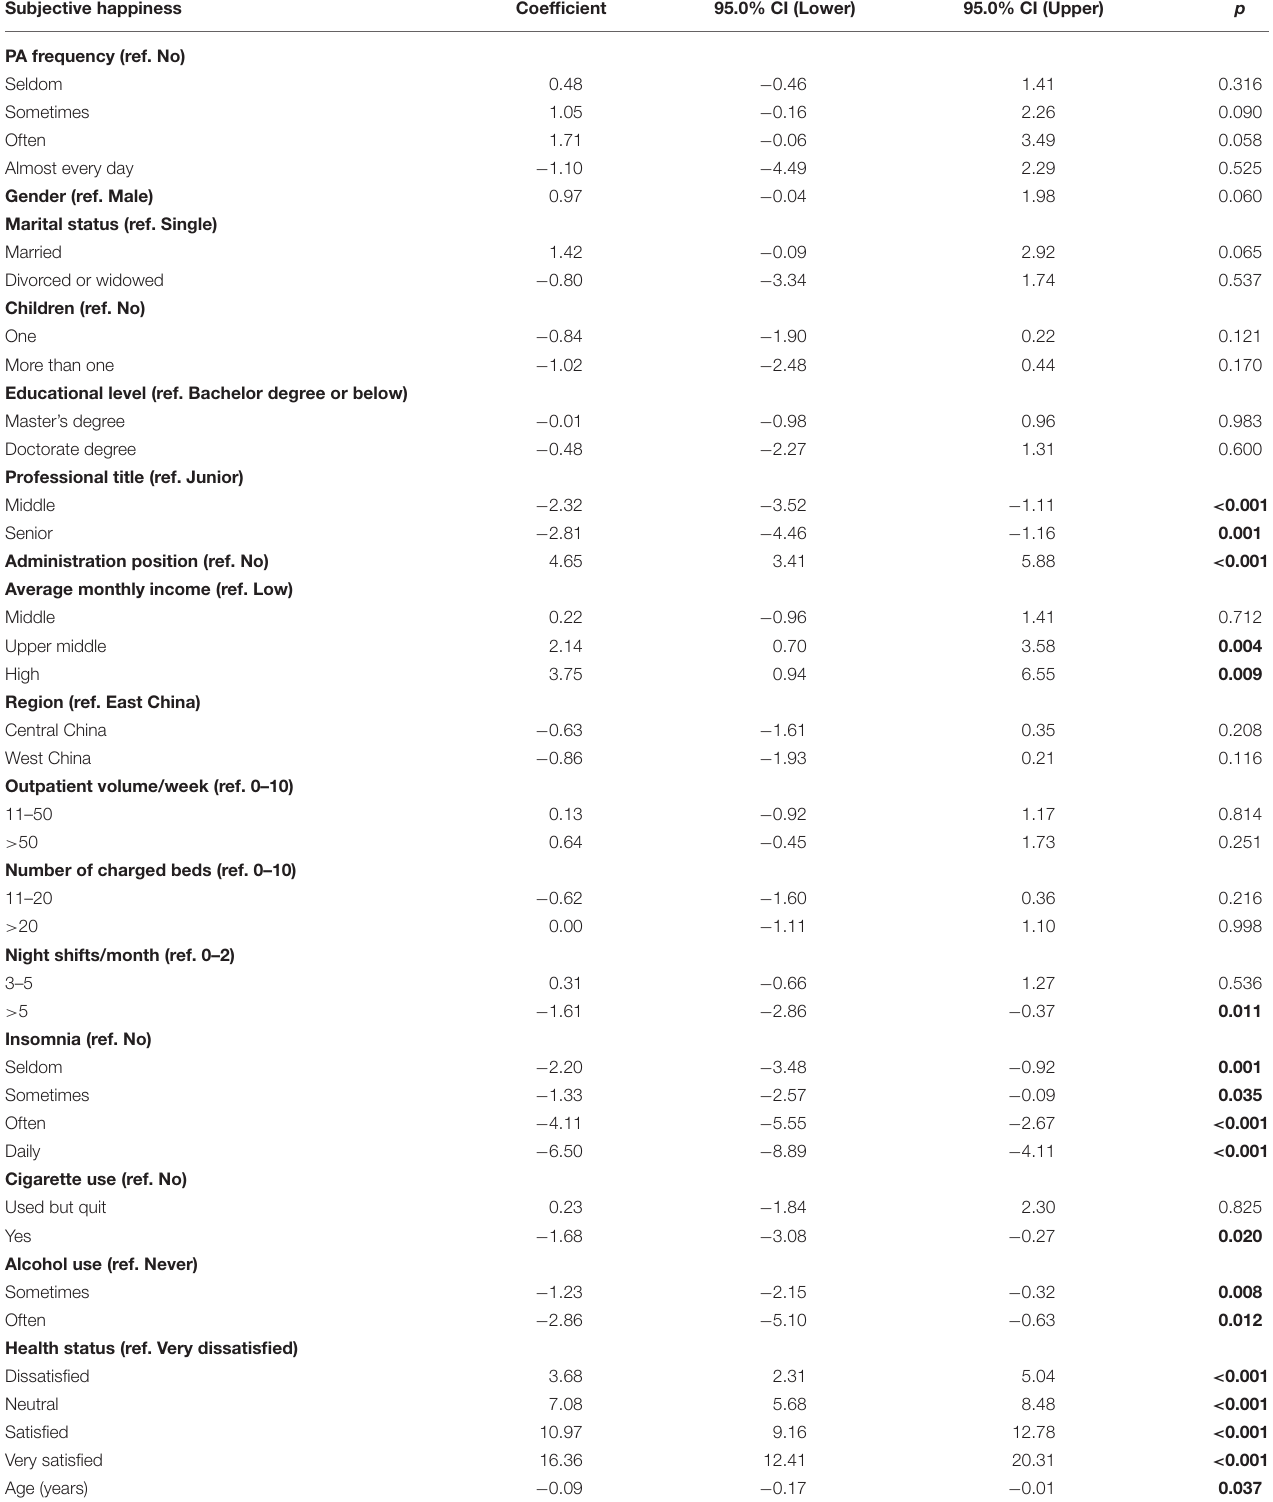
TABLE 3 | Regression examining factors associated with job satisfaction ( N = 4,520). Subjective